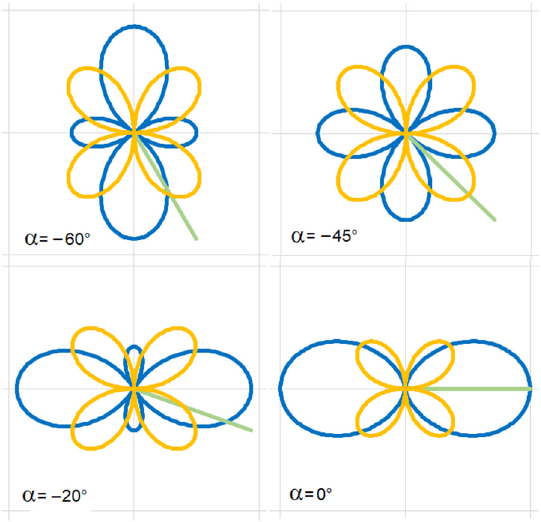
Figure 3. Symmetric tensor glyphs: 𝛼 = −60°, −45°, −20°,and 0° .